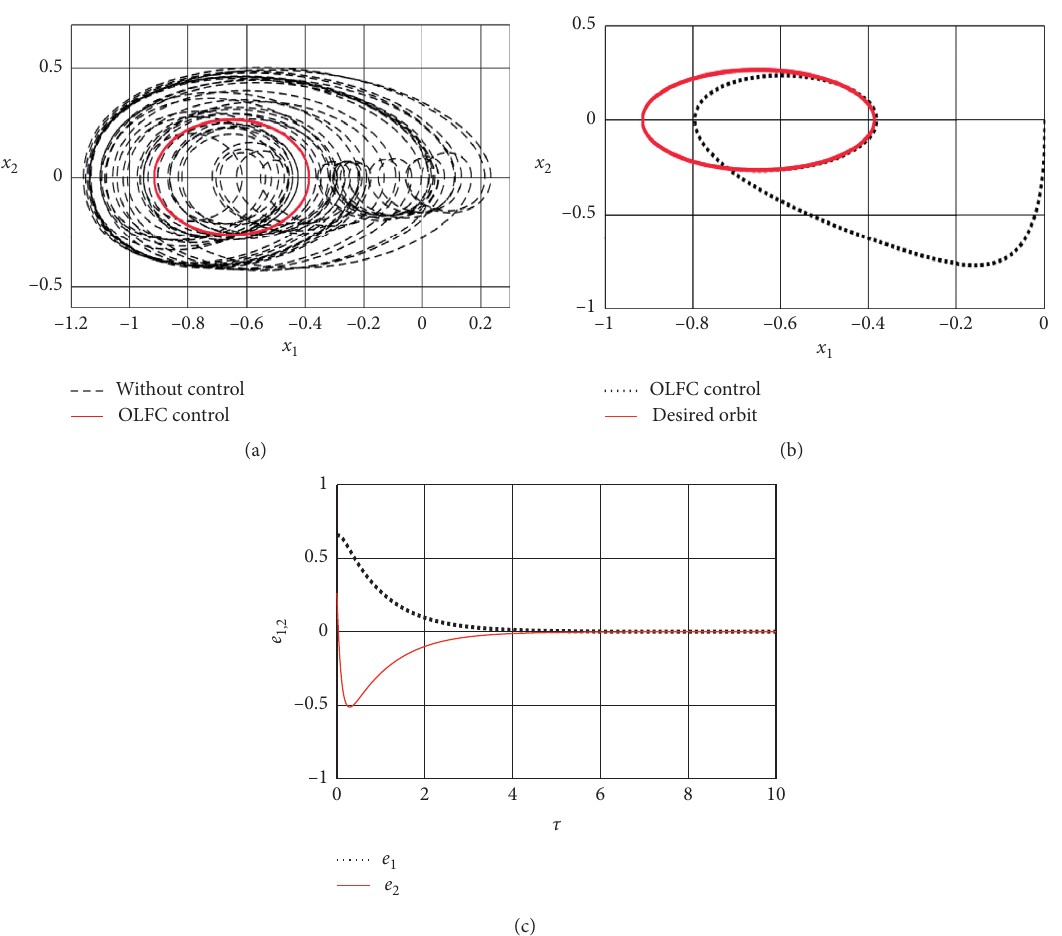
Figure 17: OLFC control: (a) phase portrait with control (solid line) and without control (dashed line); (b) trajectory of the control (dashed line) in comparison with the desired trajectory (solid line); (c) error variation e � 0 . q 3